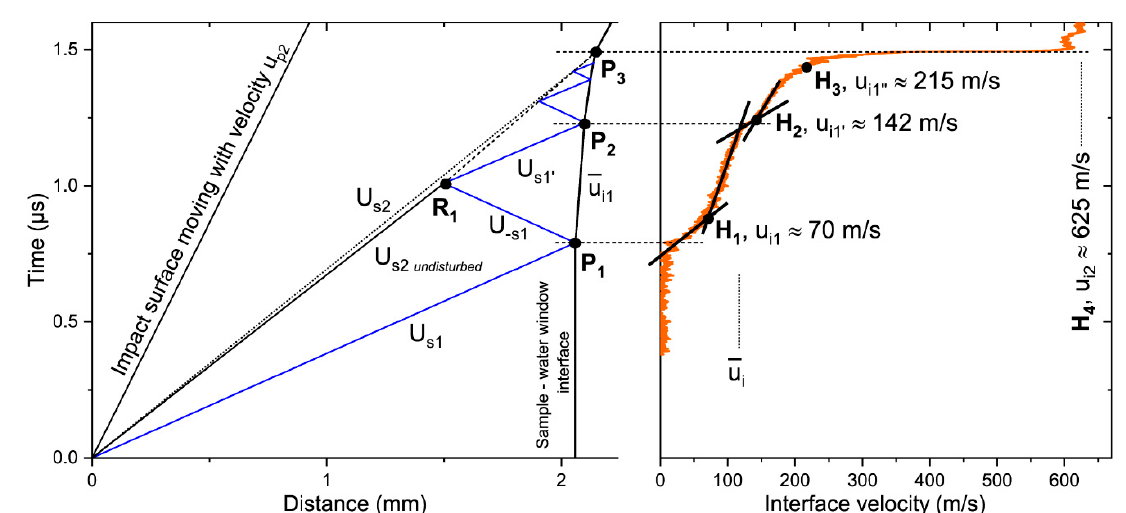
Figure 10. Distance–time diagram ( left side ) combined with the sample–water window interface velocity profile ( right side ) for Experiment 5. The time axis was the same for both plots, time t = 0 was the time of impact. The segment line connecting the points (0; 0) and P 1 shows the trajectory of the precursor inside the sample, which reached the interface at point P 1 . P 1 R 1 is the path of the first precursor reflection moving inside the sample; this reflection collides with the oncoming compaction wave in the point R 1 . R 1 P 2 is the trajectory of the first precursor reflection moving to the interface, this reflection arrives onto it at point P 2 , producing the next reverberation cycle (not marked with points). P 1 P 2 is the path of the interface after the initial precursor arrival and before the first reflection arrival. The compaction wave reaches the interface at point P 3 . The velocities drawn near the segment lines on the left side are the velocities of the related waves or surfaces. Wave paths in the sample behind the compaction wave, the impactor, and water window are not shown. Note that u i , u i 1 , u i 1 are different parameters as described in the